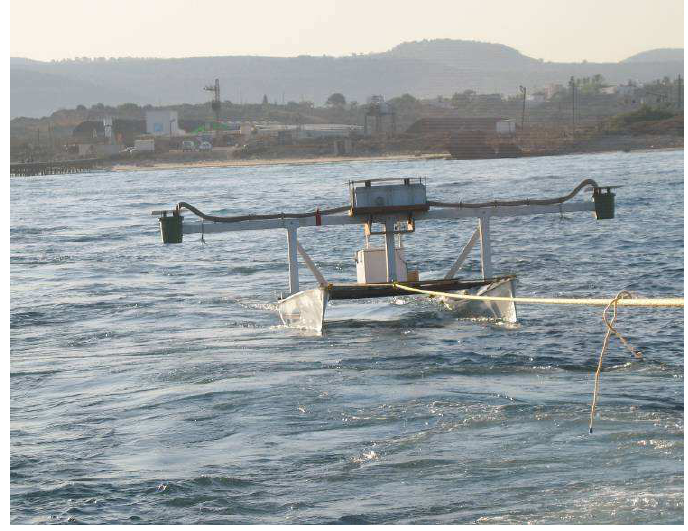
Figure 2. Survey vessel off the Atlit fortress in the Mediterranean